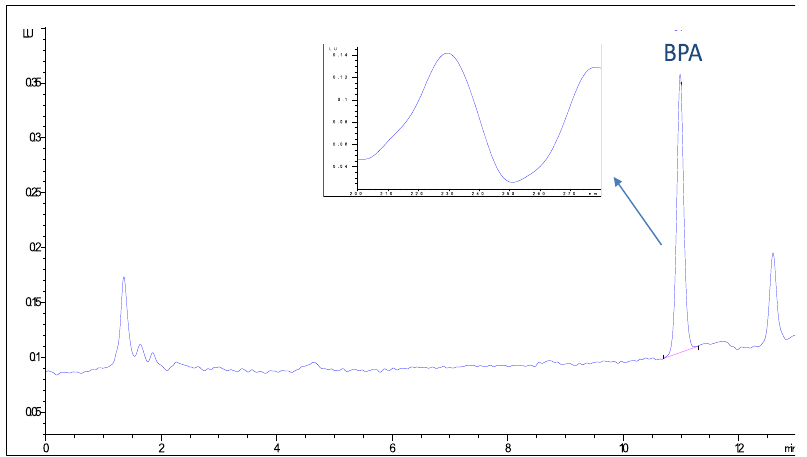
Figure1. ChromatogramsobtainedbyHPLC-FLDwitha0.005mg · kg − 1 standardsolution: luminescence Figure 1. Chromatograms obtained by HPLC-FLD with a 0.005 mg·kg − 1 standard solution: units (LU) vs. retention time (min). luminescence units (LU) vs. retention time (min).